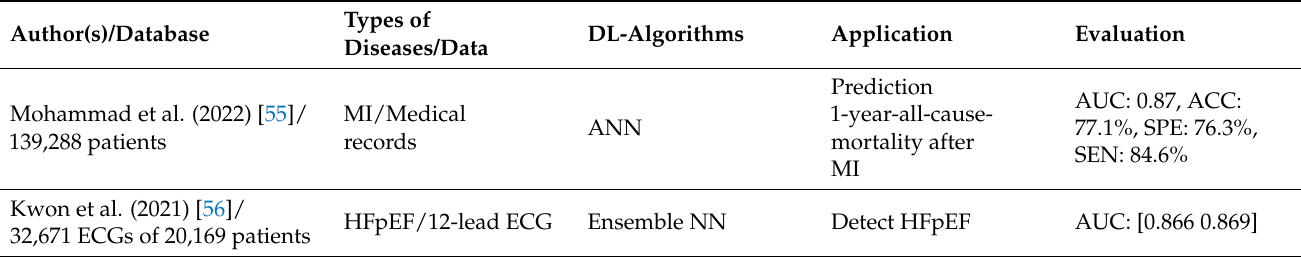
Table 2. Deep-learning-based solutions for cardiovascular diagnosis.